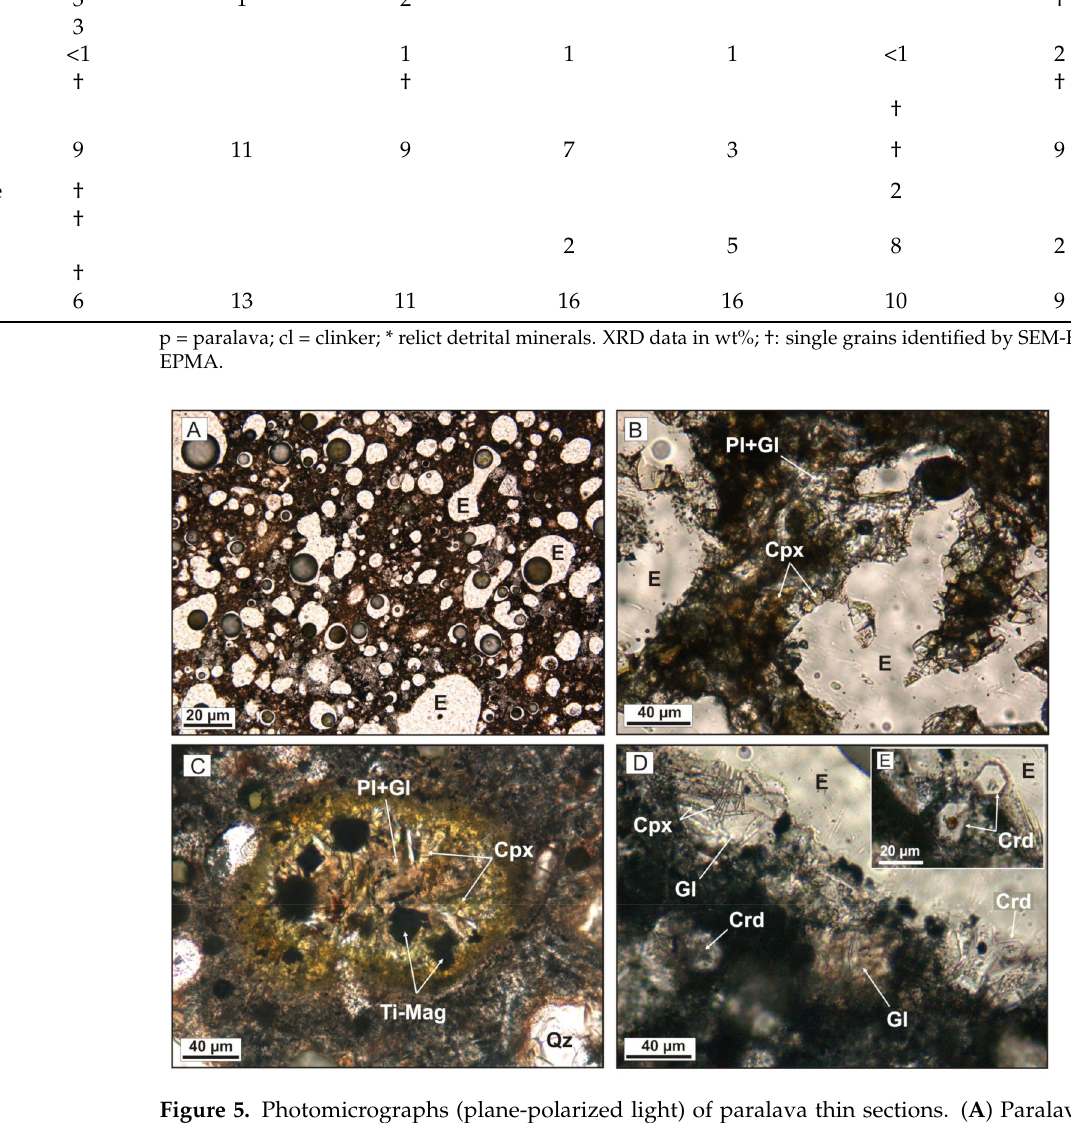
Figure 5. Photomicrographs (plane-polarized light) of paralava thin sections. ( A ) Paralava with abundant oval and elongate vesicles occupied by epoxy resin. ( B ) Pigeonite crystals and plagioclase laths in brown glass. ( C ) Cluster of ferrous spinel and pigeonite crystals with glass and plagioclase laths. ( D , E ) Prismatic Fe-rich cordierite and pigeonite laths buried in brown and colorless siliceous Al–K-rich glass. Crd = cordierite, Cpx = pigeonite, Gl = glass, E = epoxy resin, Pl = plagioclase, Qz = quartz, Ti-Mag = intermediate members of the magnetite–ulvöspinel solid